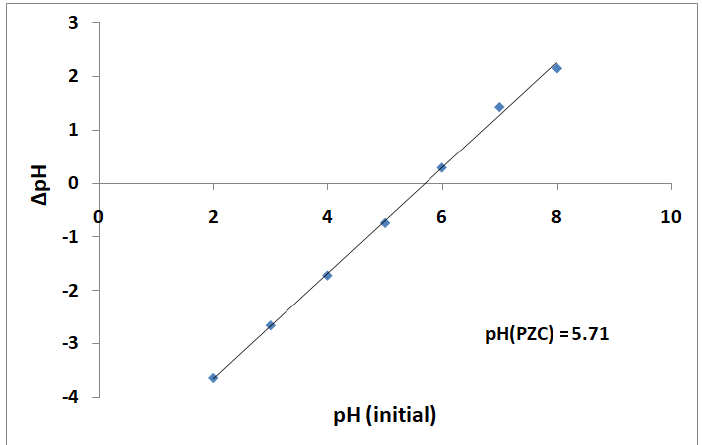
Figure 5. pHpzc of Fe – CTB.